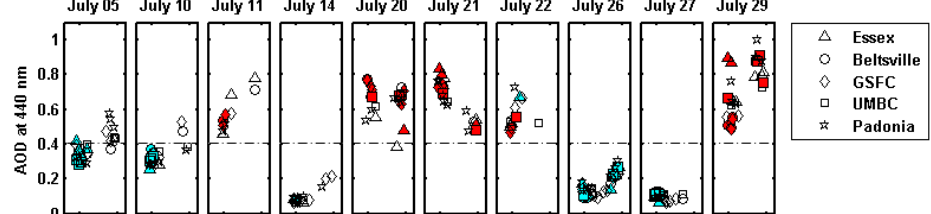
Figure 2. Aerosol optical depth (AOD) at 440nm obtained from AERONET stations at Essex, Beltsville, Goddard Space Flight Center (GSFC), UMBC, and Padonia during all 10 days during DISCOVER-AQ in which there are synergistic measurements among UC-12, P- 3B, and the ground-based lidar at UMBC. Empty symbols represent available level 1.5 retrievals of size-related products, single-scattering albedo, and complex index of refraction. Cyan-filled symbols represent available level 2.0 retrievals of only size-related products. Red-filled symbols represent available level 2.0 retrievals size-related products, single-scattering albedo, and complex index of refraction. The x axis of each window represents a day of AERONET measurement: sunrise to